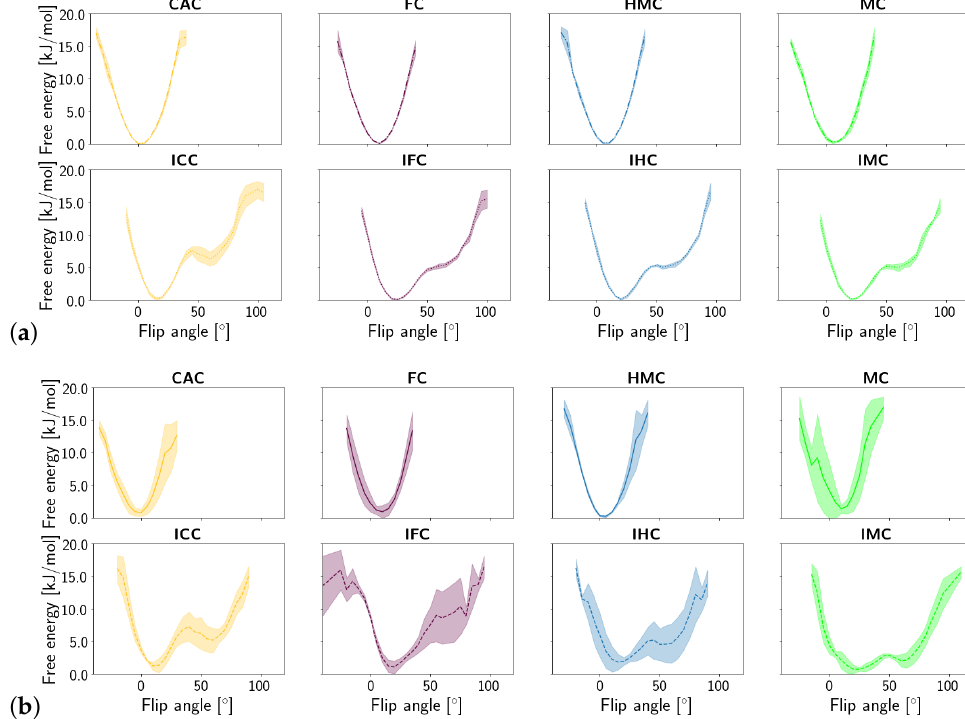
Figure 8. Free energy of the flip angle of the oxidised methyl-cytosine:guanine (G:XC) pair ( a ) in the free DNA in amino form ( top ) and imino form ( bottom ) and (b) in the DNA complexed to TDG in amino ( top ) and imino ( bottom )